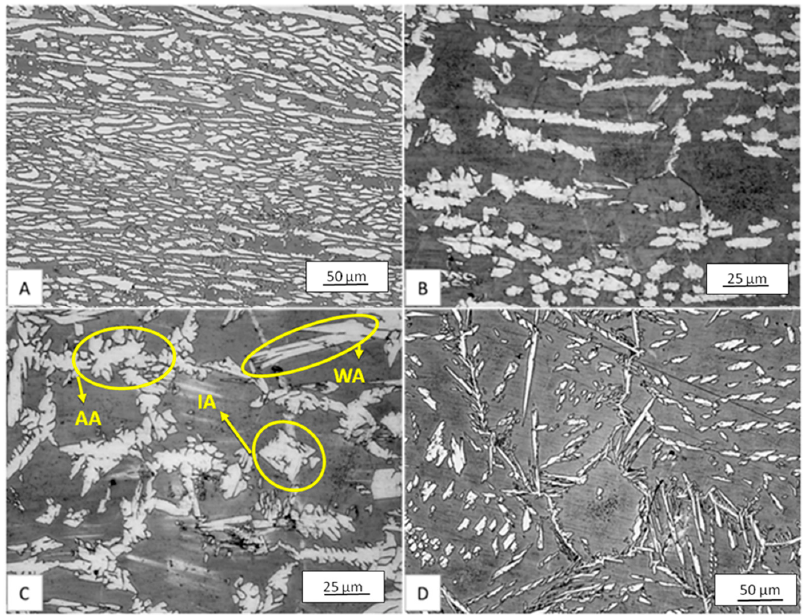
Figure 3. SAF 2205—High heat input: ( A ): BM; ( B ): LT-HAZ; ( C ): HT-HAZ; ( D ): WM; Beraha Etching. Where: ferrite—dark/dark brown, austenite—light brown, WA—Widmanstätten Austenite, IA—Intragranular Austenite; AA—Allotriomorphic Austenite .